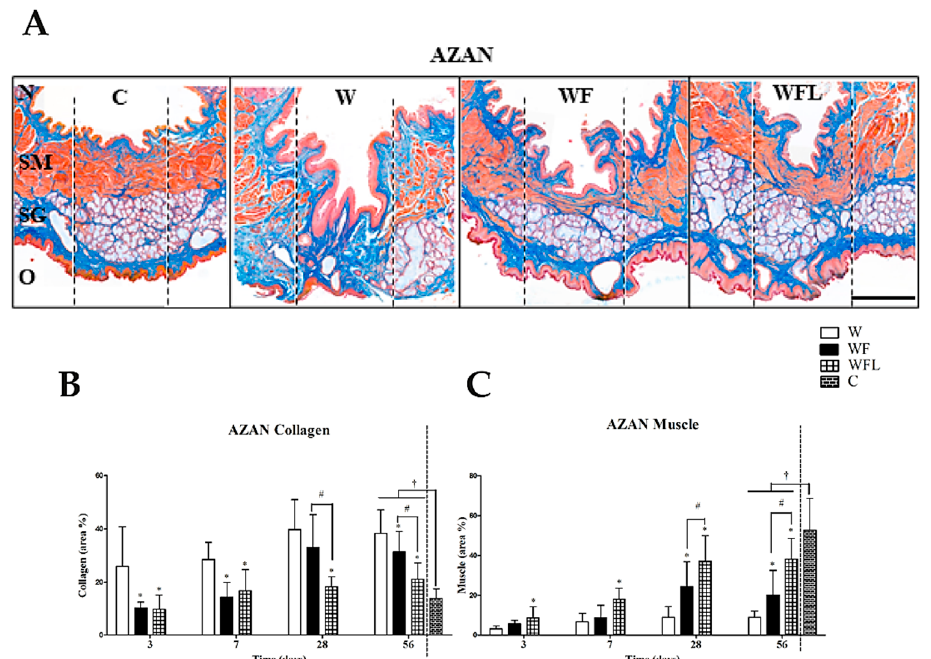
Figure 4. AZAN staining. ( A ) Representative images at day 56 (muscle in red, collagen in blue). Myofiber formation occurs mostly in fibrin-only (WF) and fibrin plus laminin-nidogen (WFL). N: nasal side of the soft palate. O: oral side of the soft palate. SM: skeletal muscle layer. SG: salivary glands. The vertical dotted lines indicate the central region of 700 µ m. The lateral regions of 500 µ m are next to it. Scale bar 500 µ m. ( B ) Quantification of collagen. The area of collagen increased over time in all three experimental groups. At day 56 the collagen areas in all experimental wounds were higher than the age control, C ( p < 0.05). Data are shown as mean ± SD. ( C ) Quantification of muscle tissue. The area of muscle tissue in WFL increased more than in the other experimental groups but remained lower than the age control ( p < 0.05). The areas between the experimental groups were compared in time using a two-way ANOVA and a Bonferroni post-hoc test. Asterisks (*) indicate significant differences with the control wounds (W) ( p < 0.05). Hash (#) indicates significant differences between fibrin-only and fibrin plus laminin-nidogen ( p < 0.05). Comparisons between the experimental groups and the age control at day 56 (†) were made using a one-way ANOVA and a Bonferroni post-hoc test ( p -value < 0.05).